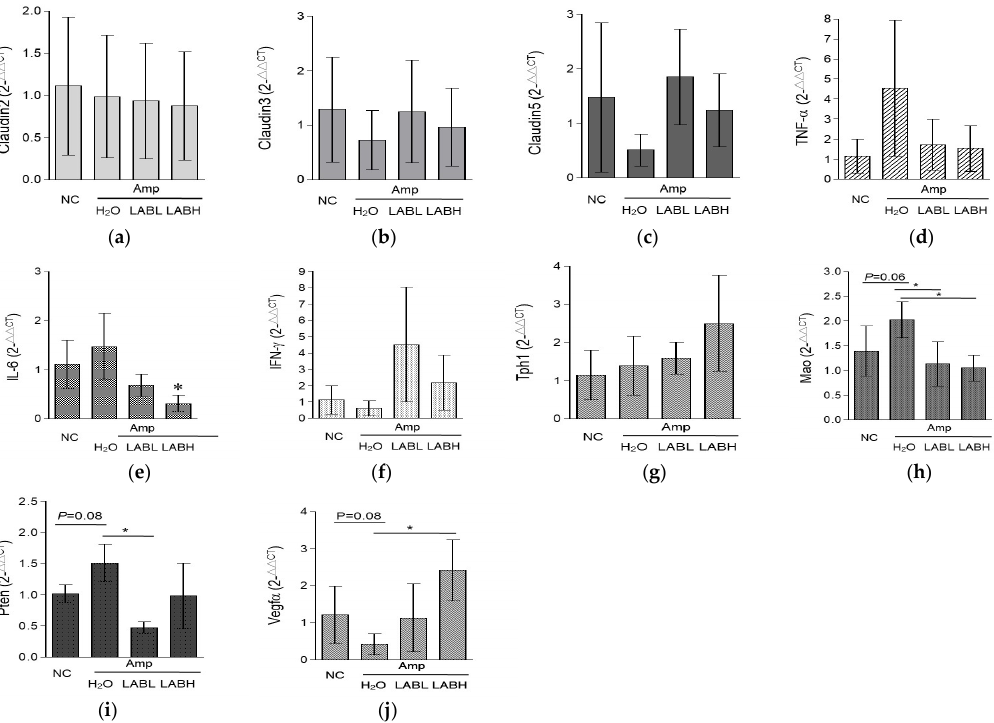
Figure 7. Effect of Lactobacillus spp. on mRNA levels of tight junction proteins and inflammatory factors in C57BL/6J mice. C57BL/6J mice ( n = 4–5/group) were grouped into the normal control (NC) group and Amp group (Amp). The groups given the three − strain composite formula were fed a dose of 1.6 × 10 8 CFU/mouse (low dosage, LABL) or 4.8 × 10 8 CFU/mouse (high dosage, LABH) from the 3rd day until the 7th day. All groups were analyzed to determine the mRNA levels of tight junction and inflammatory factors in ileum content samples on the 12th day. qRT ‒ PCR analysis of the expression of genes known to be tight junction proteins and inflammatory factors: ( a ) Claudin2, ( b ) Claudin3, ( c ) Claudin5, ( d ) IL − 6, ( e ) TNF −α , ( f ) INF −γ , ( g ) Tph1, ( h ) Mao, ( i ) Pten, and ( j ) Vegf α levels. *, compared with the Amp group, p < 0.05.